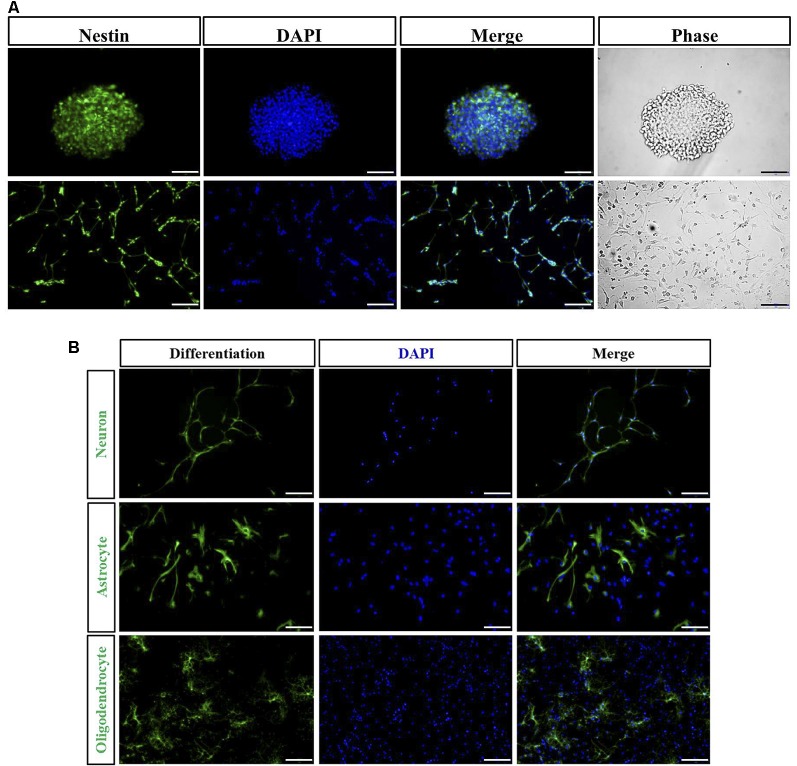
Immunocharacterization and differentiation of neural stem/progenitor cells (NSPCs). (A) NSPCs isolated from spinal cord under suspension (Bar = 50 μm) and adherent culture (Bar = 100 μm) were identified by Nestin (green), DAPI (blue), and the phase contrast images. (B) NSPCs were capable of differentiating into neurons (TUJ-1 positive), astrocytes (GFAP positive), and oligodendrocytes (O4 positive). Cell nuclei were counterstained with DAPI (blue). Bar = 100 μm.